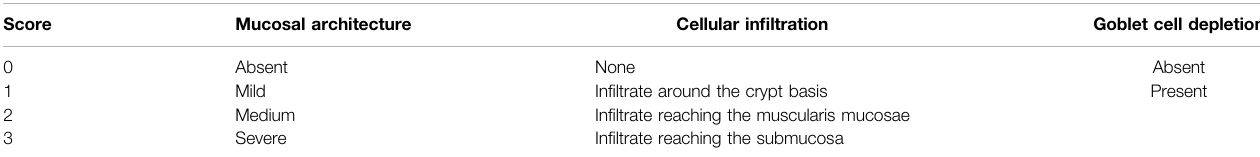
TABLE 3 | Histological scoring